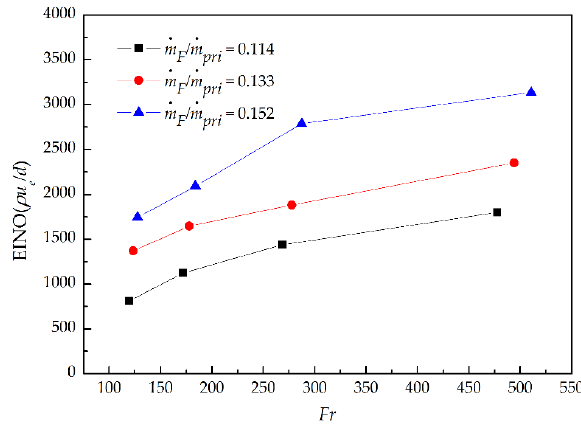
Figure 15. Variation of EINO ( ρu e / d ) with Fr under varying ṁ F / ṁ pri ratios.